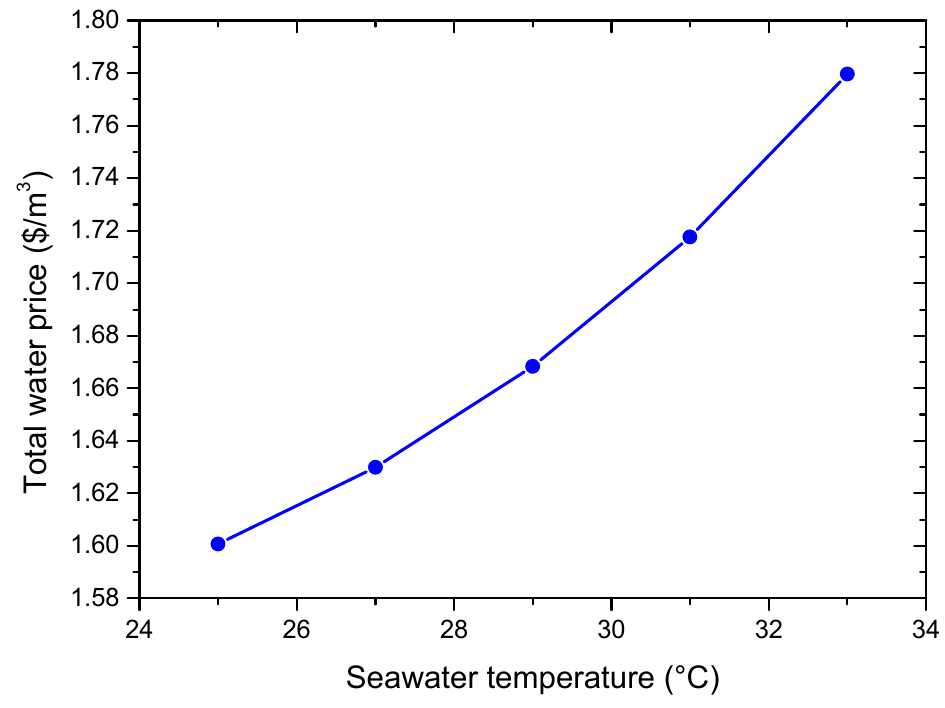
Figure 5. Effect of cooling seawater temperature on the TWP.